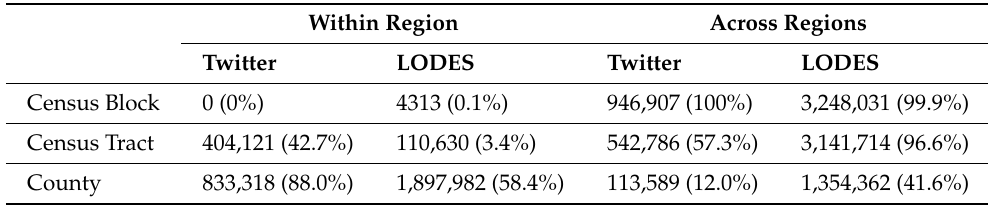
Table 5. Number of connections within and between regions by aggregation level and data source. The percentages indicate the relative share of connections for a given data source and aggrega- tion level.